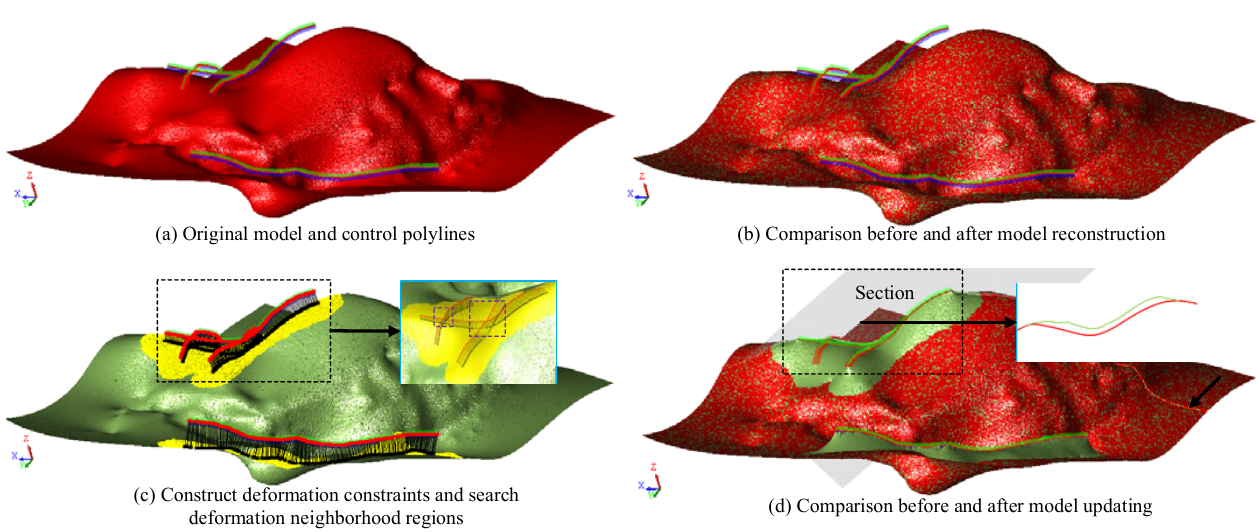
Figure 9. An example of the local updating of a geological body model ( a – d ).